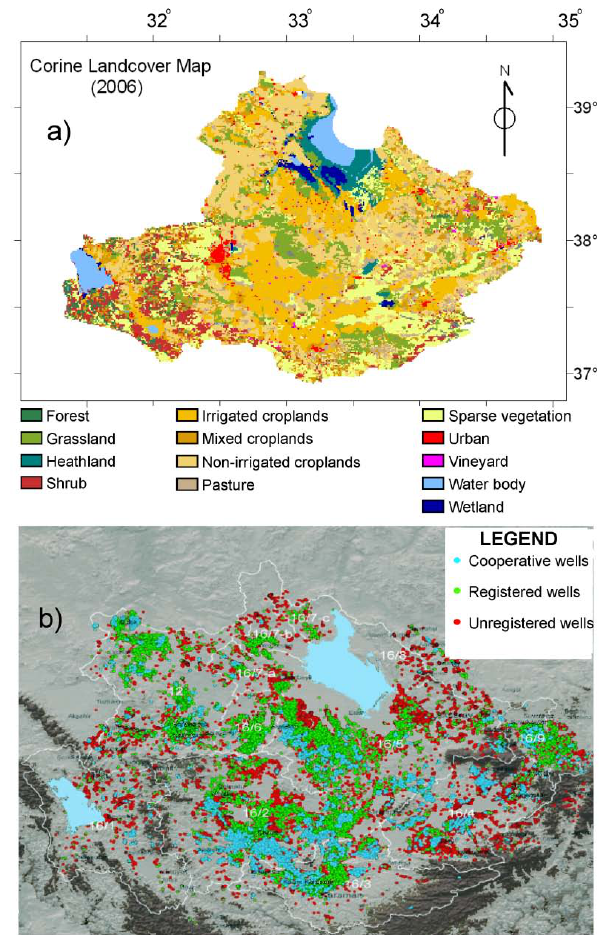
Fig. 2. (a) Corine land cover classification map of the Konya Basin (source: Ministry of Environment and Forestry); (b) distribution of the groundwater abstraction wells in and around the Konya Basin (source: unpublished data by State Hydraulic Works, DSI).